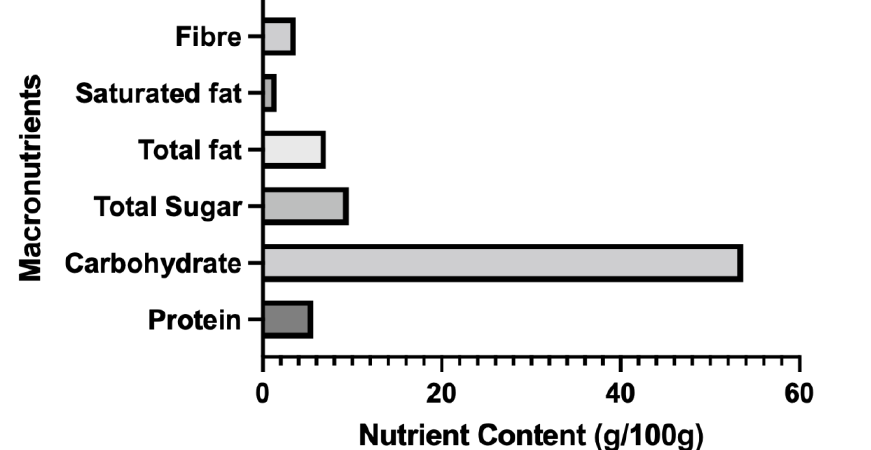
Figure 1. Nutrient content in g/100 g for gluten-free foods across 12 different food categories. The data are presented as mean values.